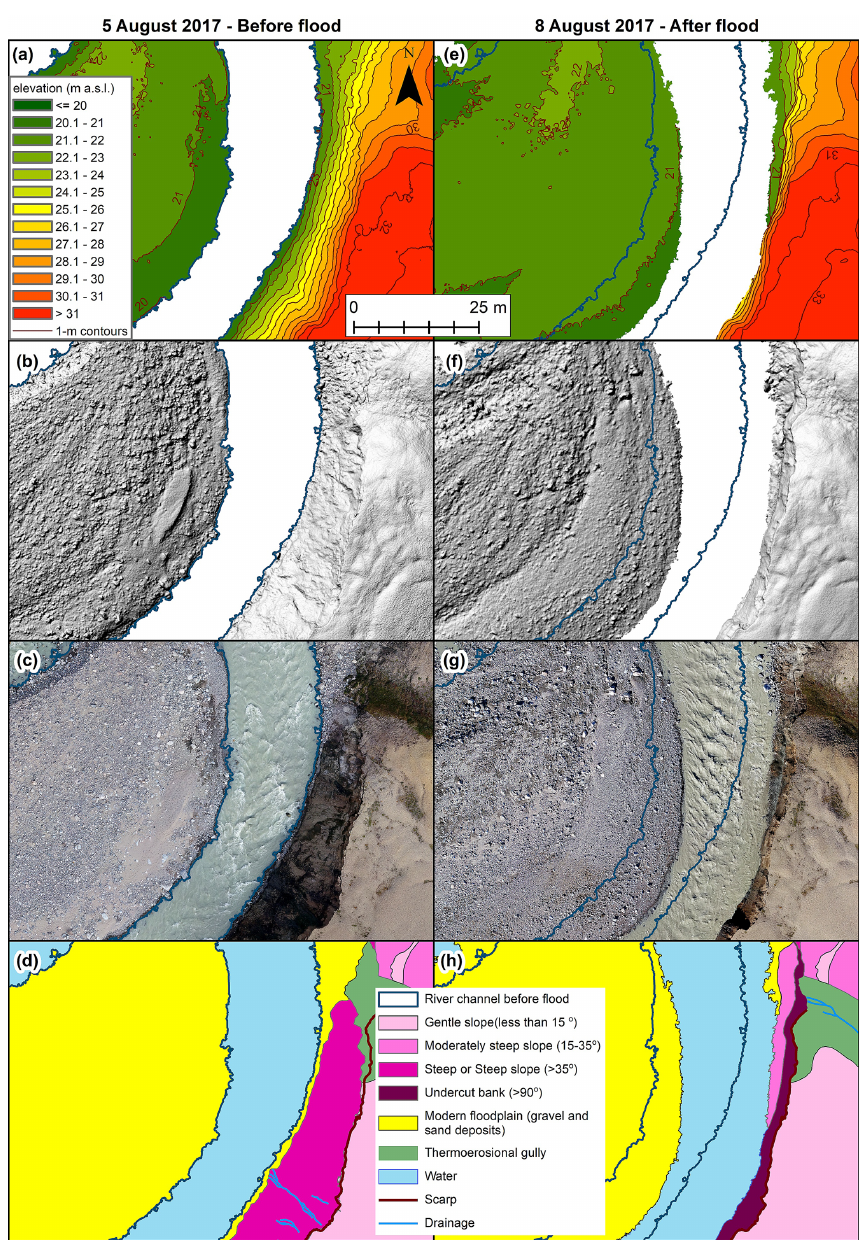
Figure 3. Examples of the delivered dataset illustrating before and after the flood situation: (a, e) digital elevation model; (b, f) hillshade model; (c, g) orthomosaics; (d, h) results of geomorphological mapping.